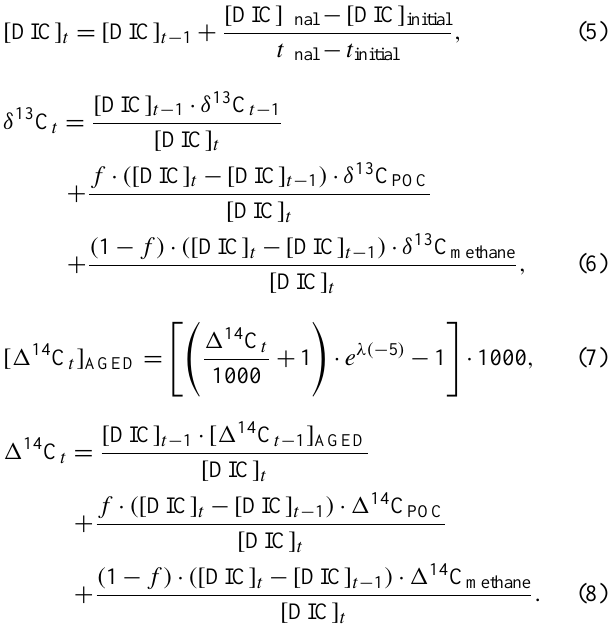
Fig. 3. Box modeled results for the 1 14 C value of DIC (solid black line) over the 8078 radiocarbon-year history of Orca Basin brine plotted along with dashed lines representing uncertainty in model results. The solid gray line represents 1 14 C values of POC in- put driven by IntCal09 (Reimer et al., 2009) adjusted for a local reservoir age from the nearby Flower Garden Banks (Wagner et al.,